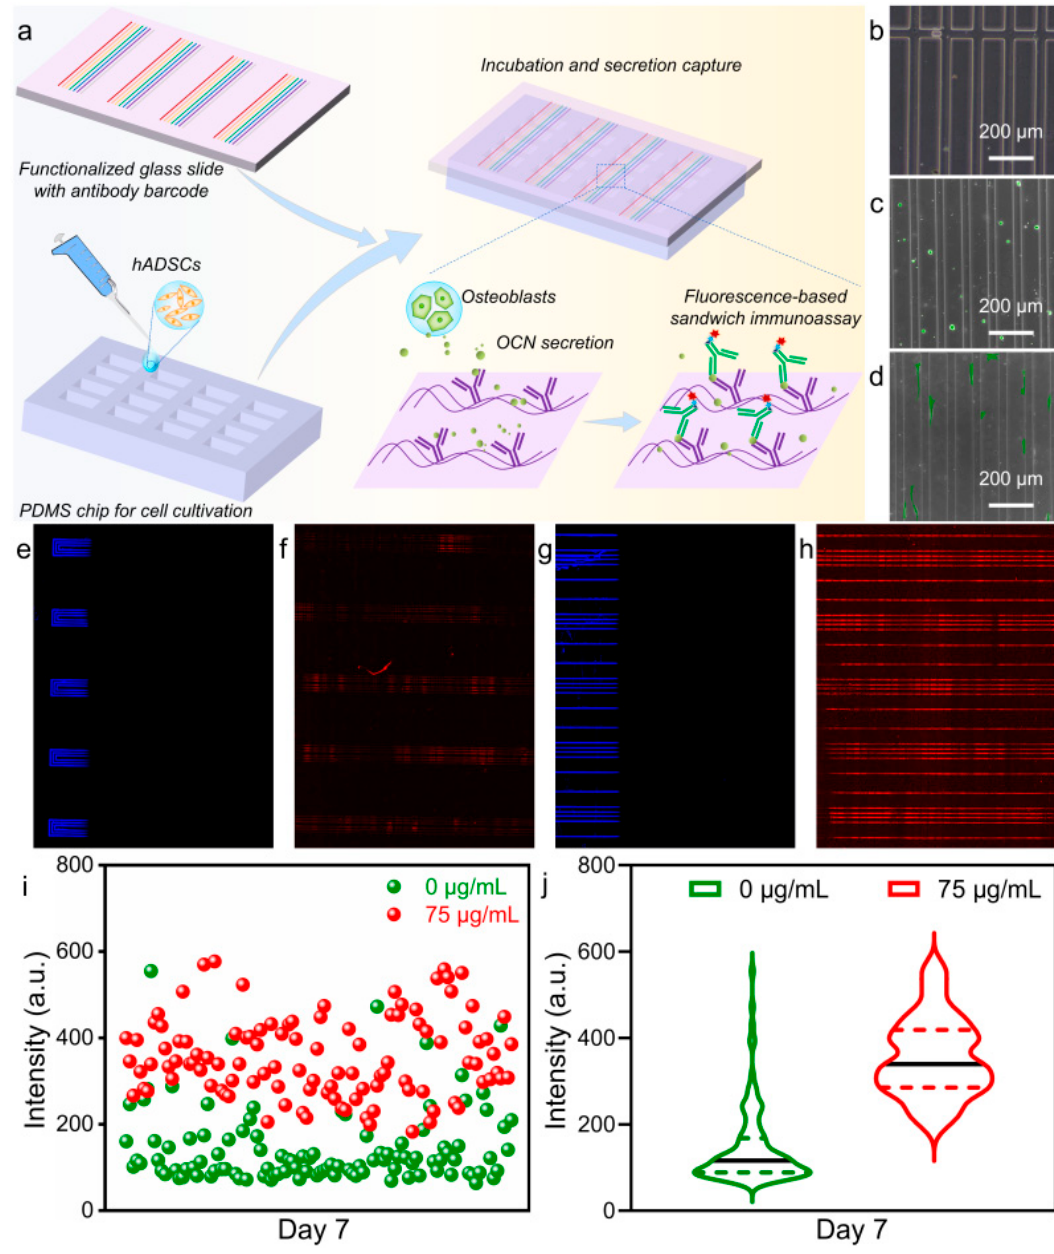
Figure 7. ( a ) Schematic of hADSC-secreted OCN protein detection by a polydimethylsiloxane (PDMS) microfluidic chip and a functionalized glass slide with antibody barcodes. ( b ) Pure PDMS chip in bright field. ( c ) Cell seeded on the PDMS chip at 0 h. ( d ) Cell morphology after being seeded on the PDMS chip for 24 h. Detection of capture antibody spreading on the glass slide ( e , g ) and fluorescence signal image of the antibody-barcoded glass slide ( f , h ) cultured with 0 and 75 µ g/mL MNPs, respectively. ( i ) Scatter diagram showing the distribution of fluorescence intensity after 7 days of cultivation on hADSCs with 0 and 75 µ g/mL MNPs. ( j ) Violin plot showing the average fluorescence intensity after 7 days of culture with 0 and 75 µ g/mL MNPs on